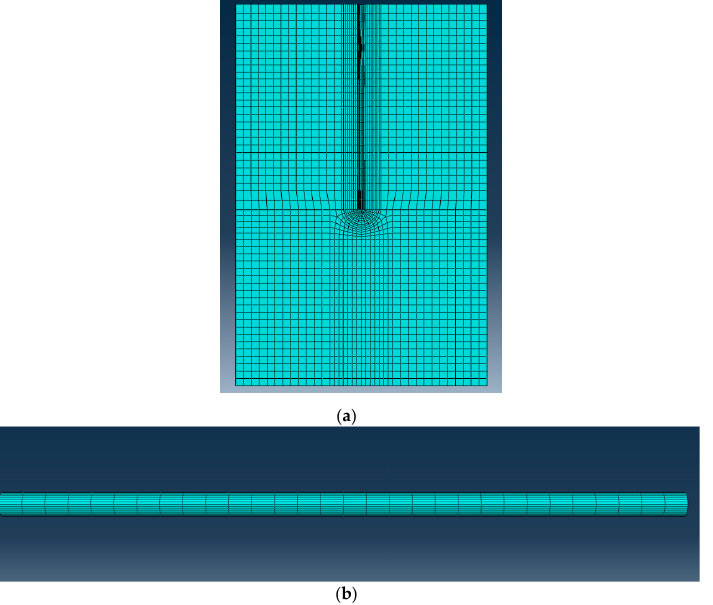
Figure 10. Schematic diagram of the ABAQUS model. ( a ) Soil grid division; ( b ) Grid division of PHC pipe